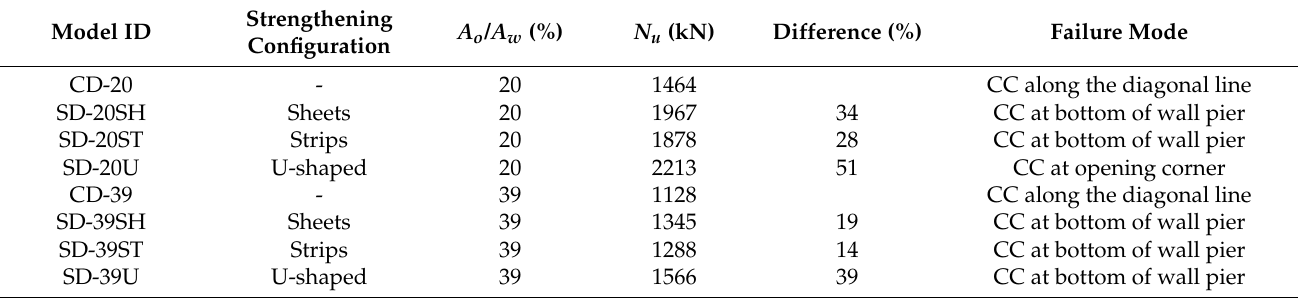
Table 6. Results of wall models with various strengthening